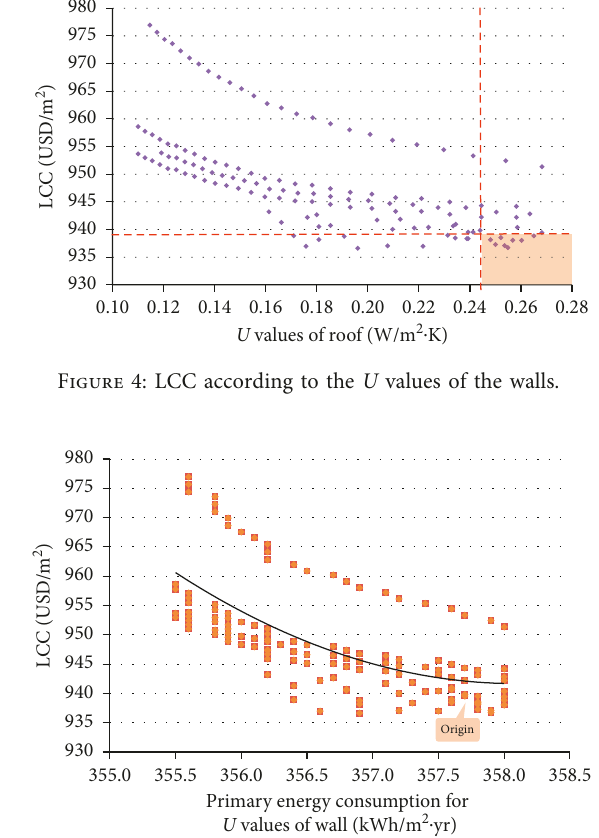
Figure 5: LCC according to the primary energy use for the U values of walls.